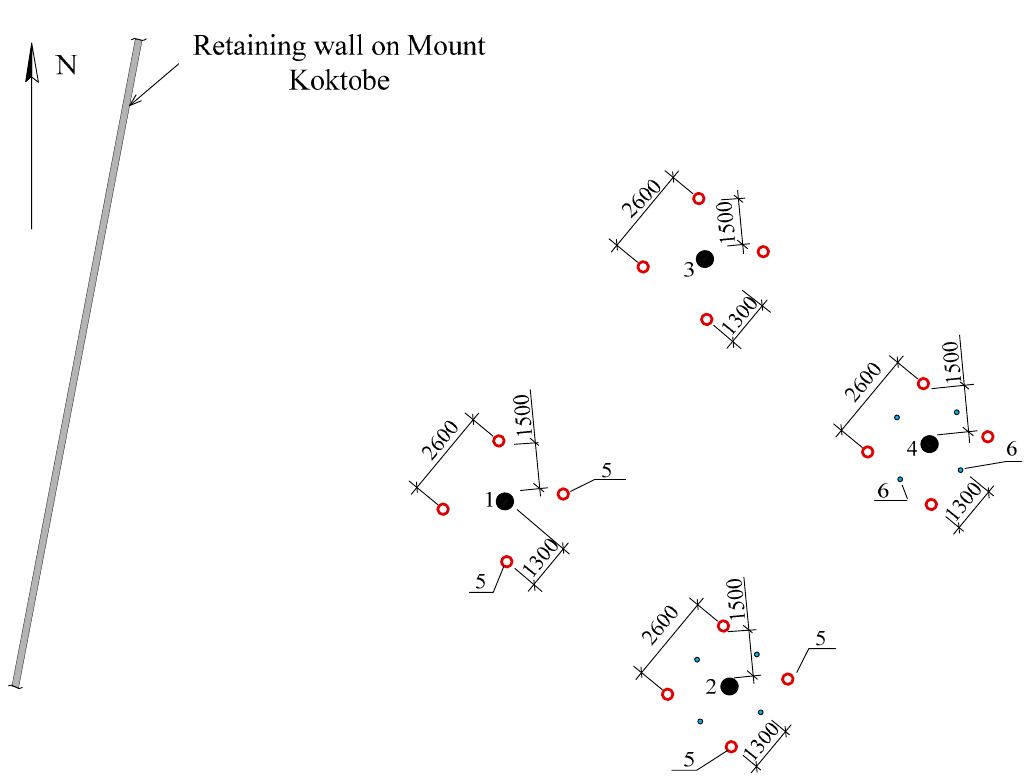
Figure 5. Location of experimental piles at the construction site “Retaining wall on Mount Koktobe in Almaty.” 1—ordinary bored piles without soil wetting; 2—ordinary bored piles, with soil wetting; 3—cast-in situ concrete pile in the protective shell, without soil wetting; 4—cast-in situ concrete pile in the protective shell, with soil wetting; 5—anchor piles; 6—drainage tube.